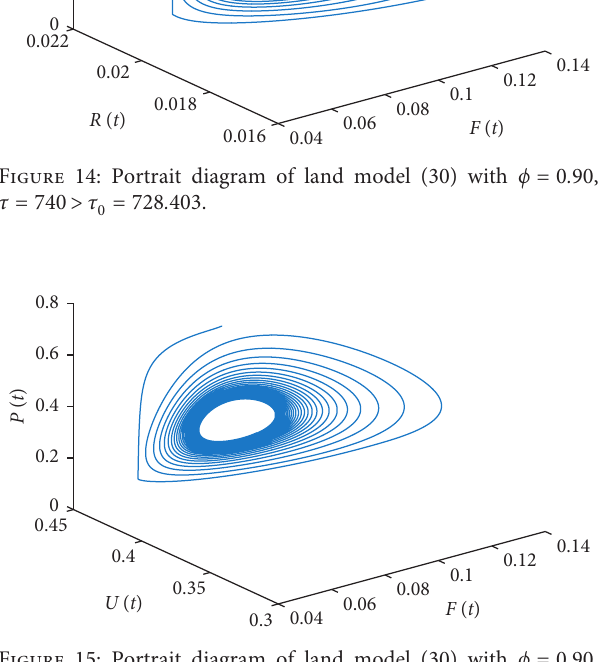
Figure 15: Portrait diagram of land model (30) with ϕ � 0 . 90, � 728 . 403. τ � 740 > τ 0